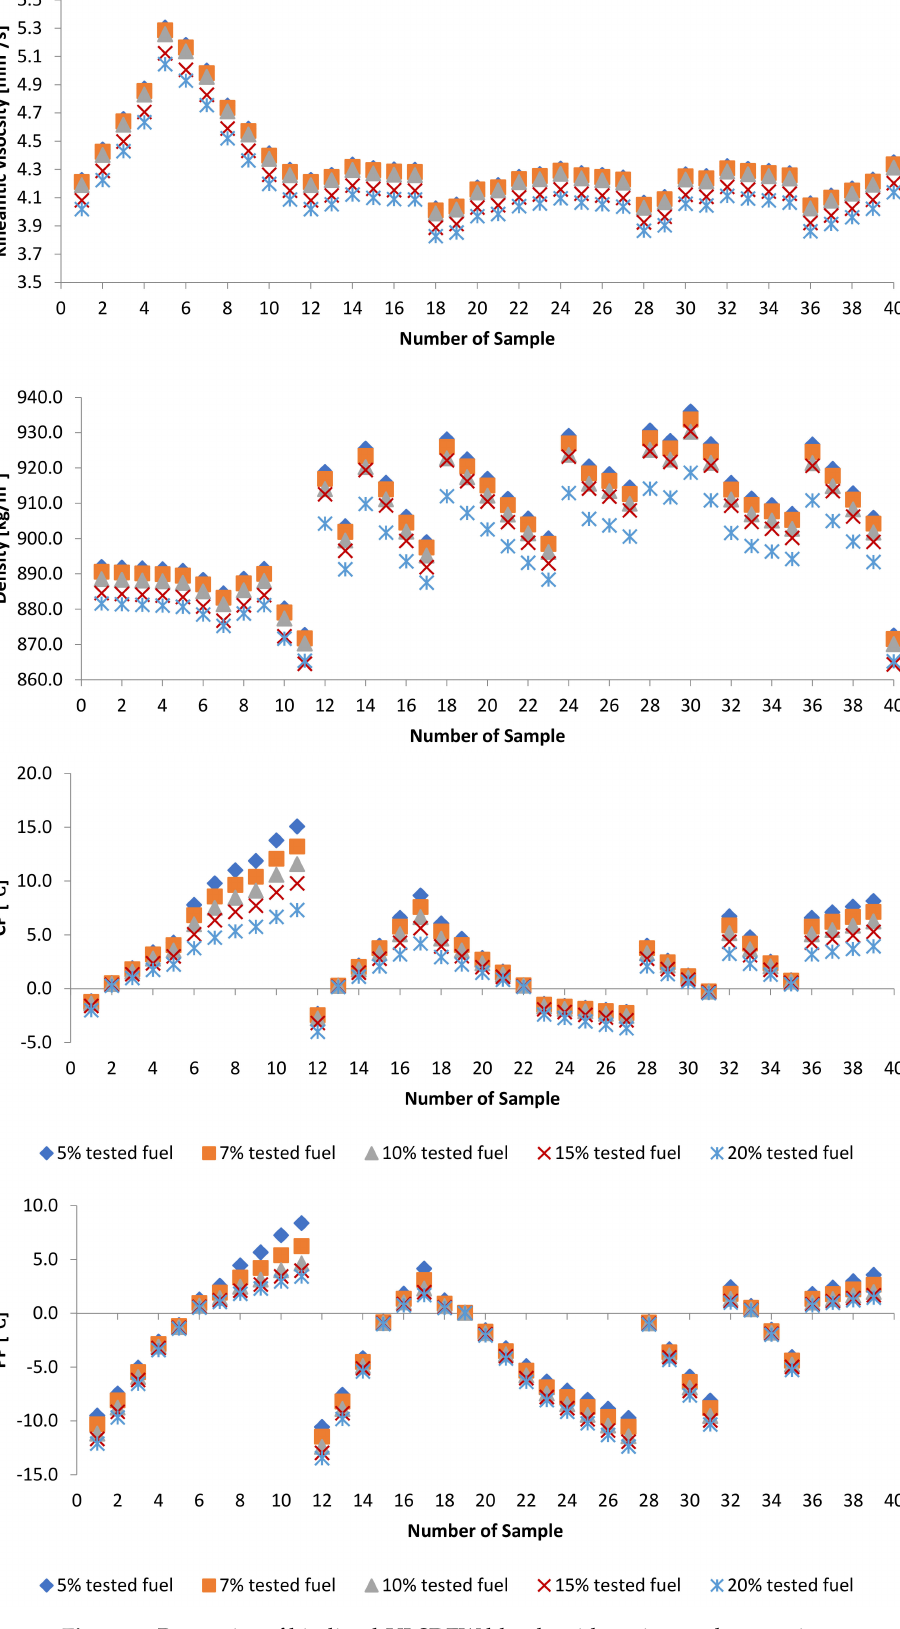
Figure 6. Properties of biodiesel-ULSDFW blends with various volume